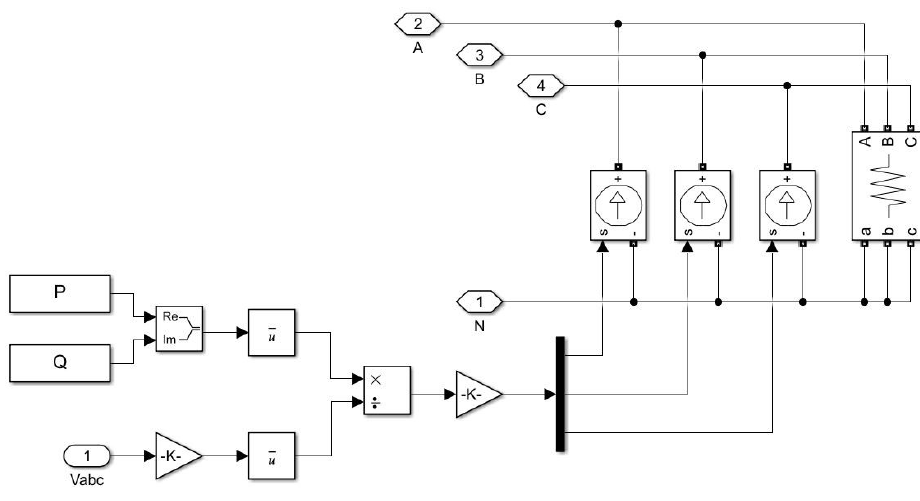
Figure 3. Industrial consumption model in MATLAB